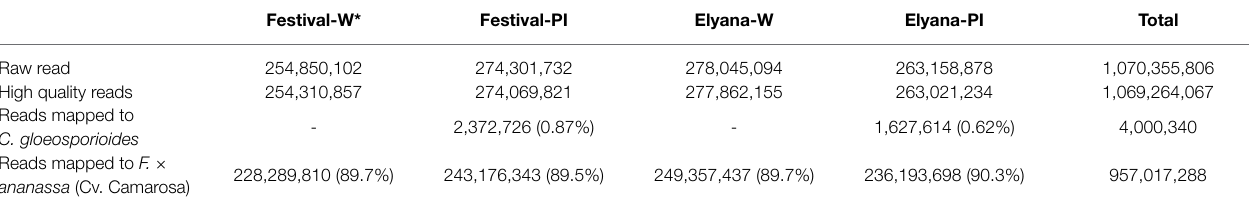
TABLE 2 | Summary of the transcriptome sequencing dataset from ‘Strawberry Festival’ and ‘Florida Elyana’ after the infection of Colletotrichum gloeosporiodes